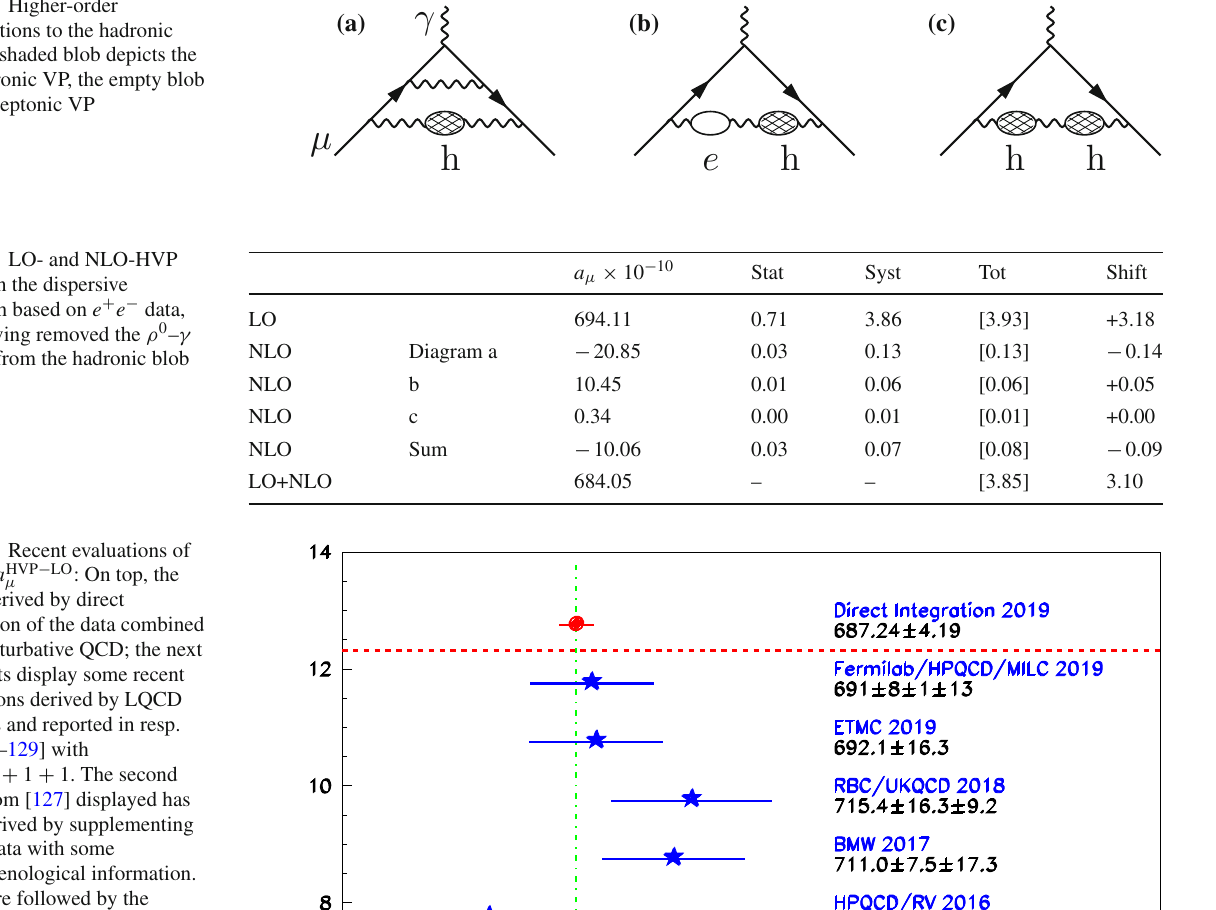
results in the dispersive approach based on e + e − data, after having removed the ρ 0 – γ